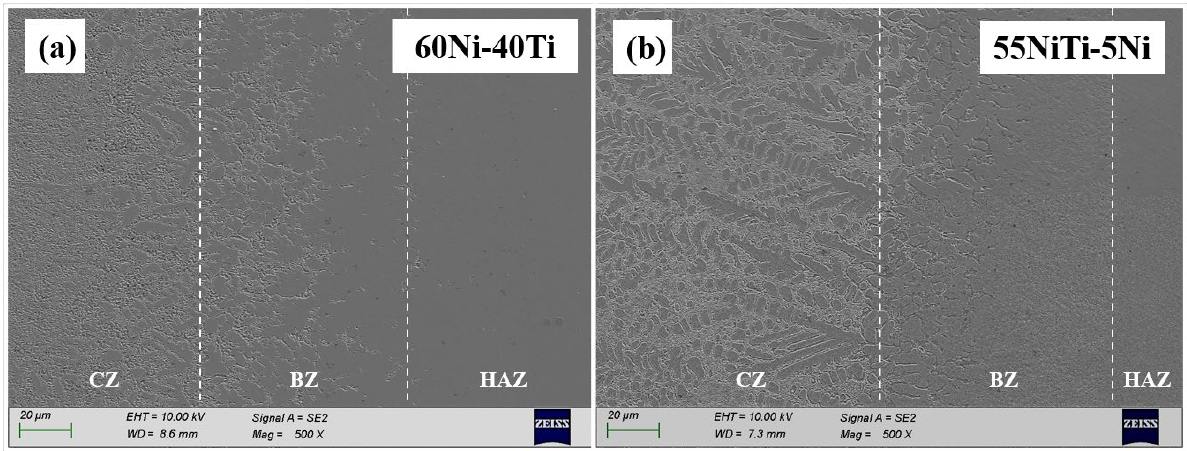
Figure 4. SEM images of the bonding zone of coatings: ( a ) 60Ni-40Ti; ( b ) 55NiTi-5Ni. The Top, Mid and Bot areas of the two coatings were observed by SEM, and the chemical composition was analyzed with EDS. It was found that the microstructure of the two coatings at different areas was almost similar. The Top area of the coatings was se- lected for microstructure investigation and acted as the working face of the electrochemi- cal behavior test. As shown in Figure 5a–c, similar to the laser cladding mixed pure pow- ders, 60Ni-40Ti tends to form a eutectic network structure. However, 60Ni-40Ti coating grows with a coarse network structure and fine network structure alternately, which is different from the laser cladding of nickel–titanium pure mixed powders [17,27]. As ex- hibited in Figure 5d–f, 55NiTi-5Ni shows a typical dendritic eutectic structure, which is composed of coarse dendritic and interdendritic eutectic structures. In contrast to the coat- ing of laser cladding 55NiTi alloy powder, the eutectic structure in 55NiTi-5Ni is finer. In addition, black petal-like precipitates were observed in both coatings. The size of the pre- cipitates was about 5 μm with different shapes, and they mainly grew on the grain bound- aries. Figure 5g–i shows the microstructure of the two coatings at a 2000 × where the over- all grain size of 55NiTi-5Ni coating is much finer than that of 60Ni-40Ti coating. It is due to the dense dendritic structure of 55NiTi-5Ni and the fine eutectic structure between them.